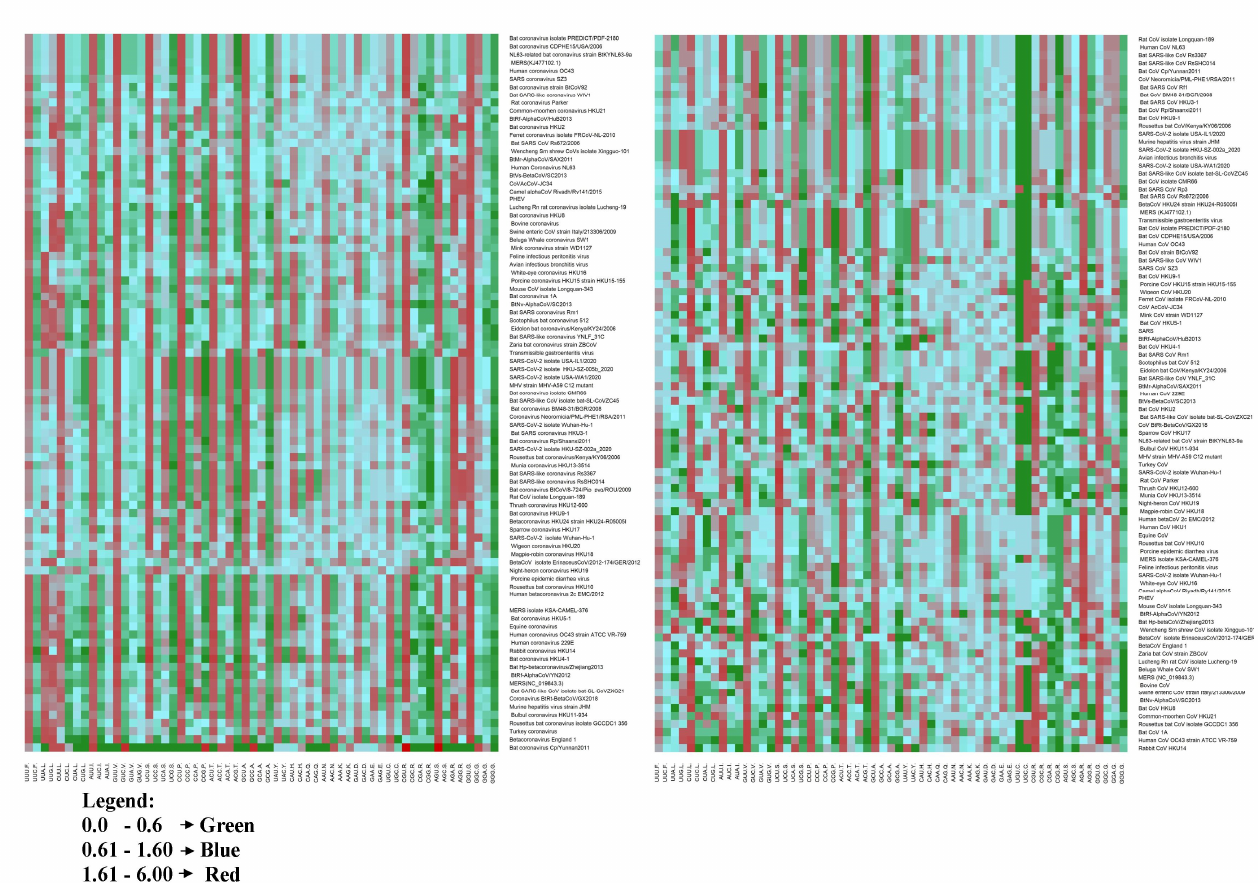
Figure 1. Heat map of the S and N genes based on relative synonymous codon usage (RSCU) values: A heat map plot of S (Left) and N gene (Right) based on the RSCU values for the viruses belonging to the Coronaviridae family. The RSCU values were generated from the CodonW v. 1.4.2 software. Colors represent over-represented and under-represented codons for the genes analyzed. The under-represented genes synonymous codons (RSCU < 0.6) are in green color, Over-represented synonymous codons (RSCU > 1.6) are in Red, the rest are in blue. Abbreviation in figure legends: Porcine hemagglutinating encephalomyelitis virus (PHEV); Mouse hepatitis virus (MHV); Wuhan seafood market pneumonia virus